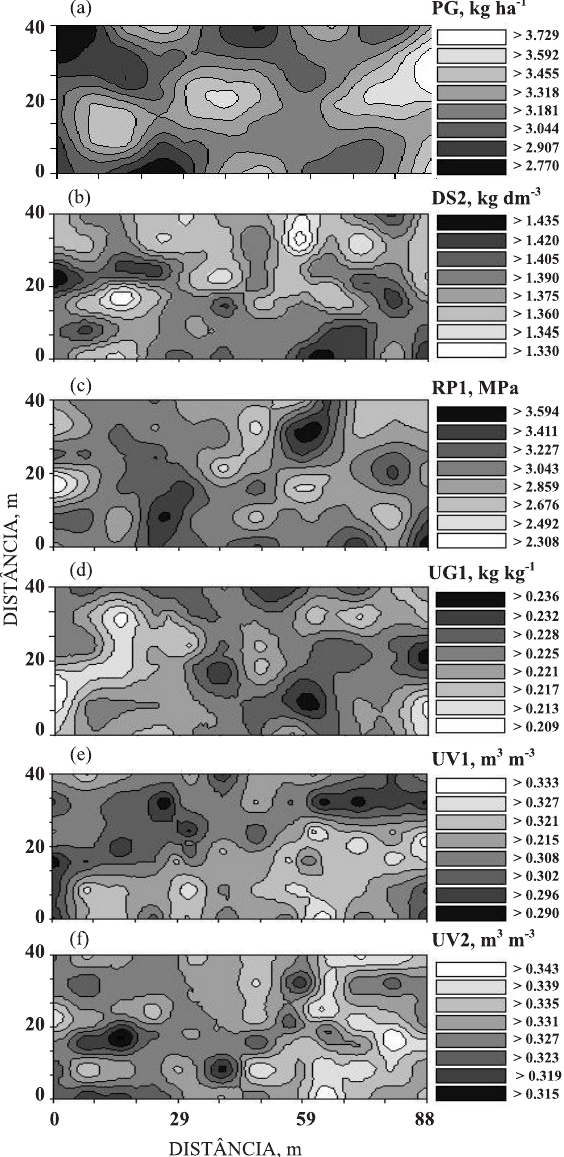
Figura 2. Mapas de krigagem simples da produtivi- dade da soja e de alguns atributos físicos de um Latossolo Vermelho distroférrico de Selvíria (MS).